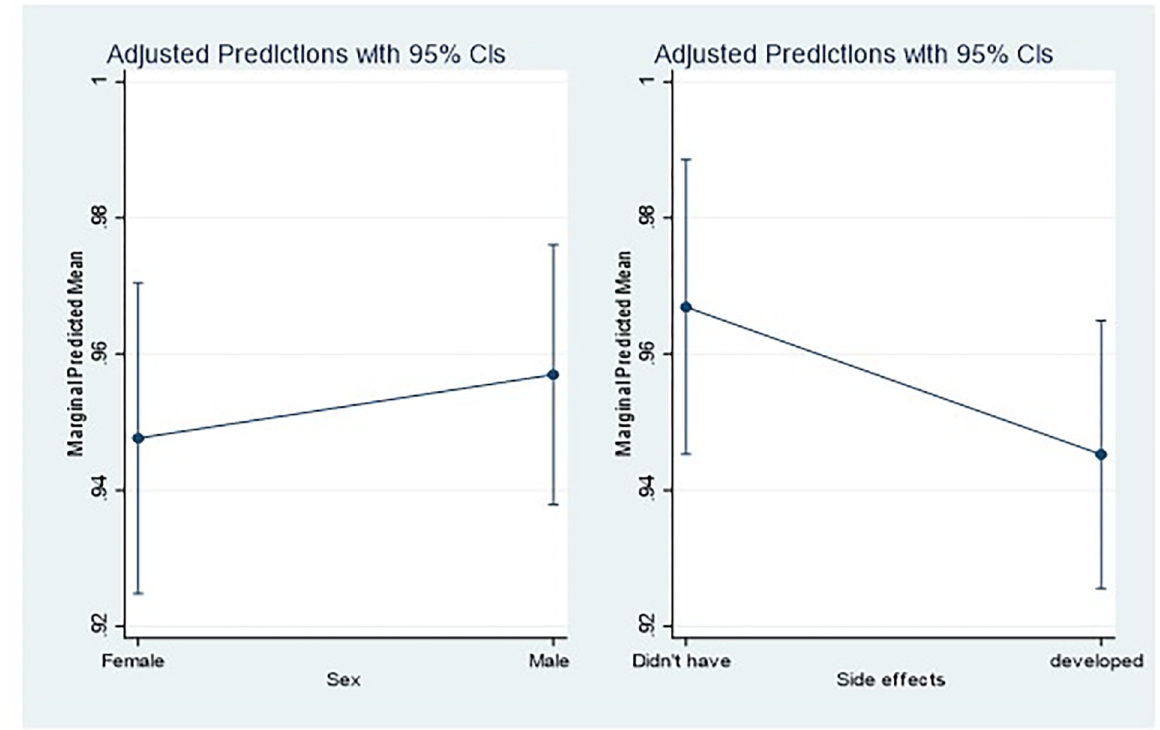
Fig 1. Margins plot on intention to getting a second dose of Astra Zeneca